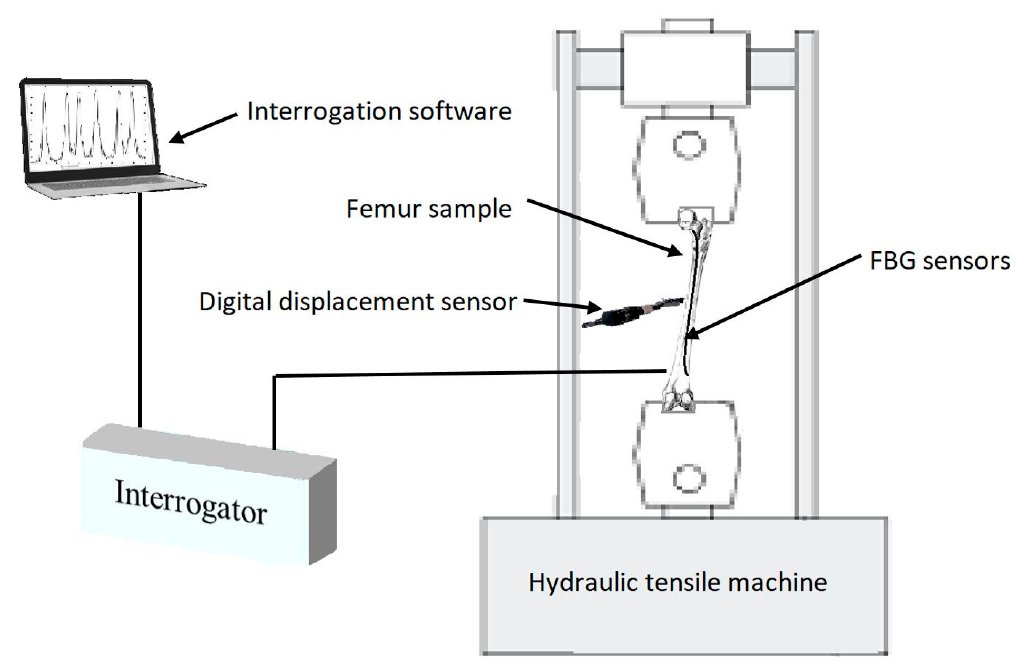
Figure 3. Schematic view of the experimental setup.